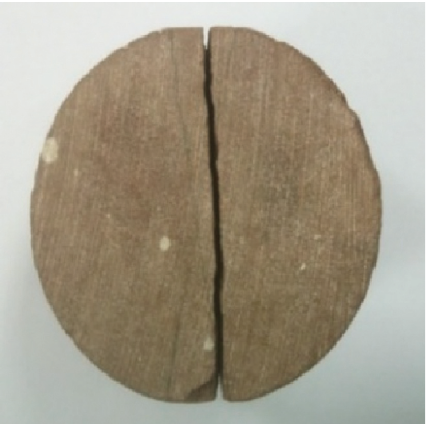
Figure 6: Failure pattern of the flattened Brazilian disk